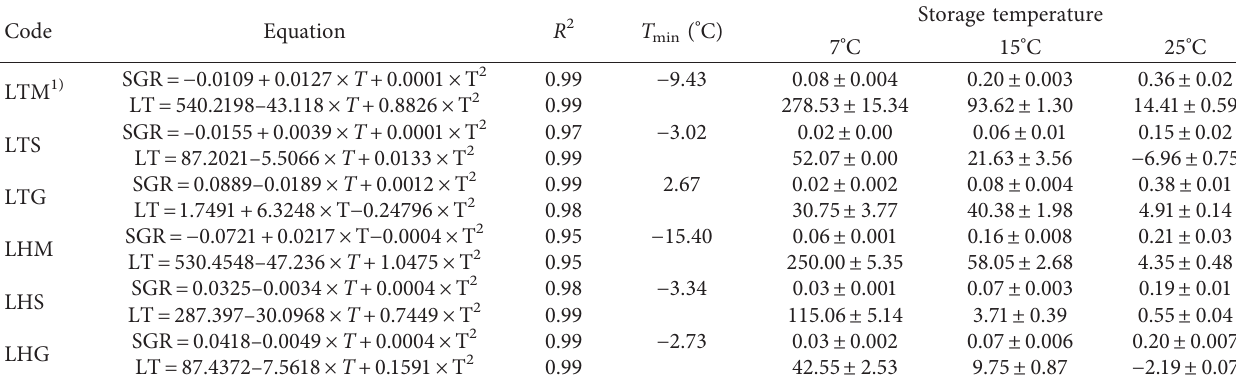
Table 1: Secondary models developed for the specific growth rate (SGR, log CFU/g/h) and lag time (LT, h) of L . monocytogenes in rice balls and statistical validation factors calculated for Baranyi